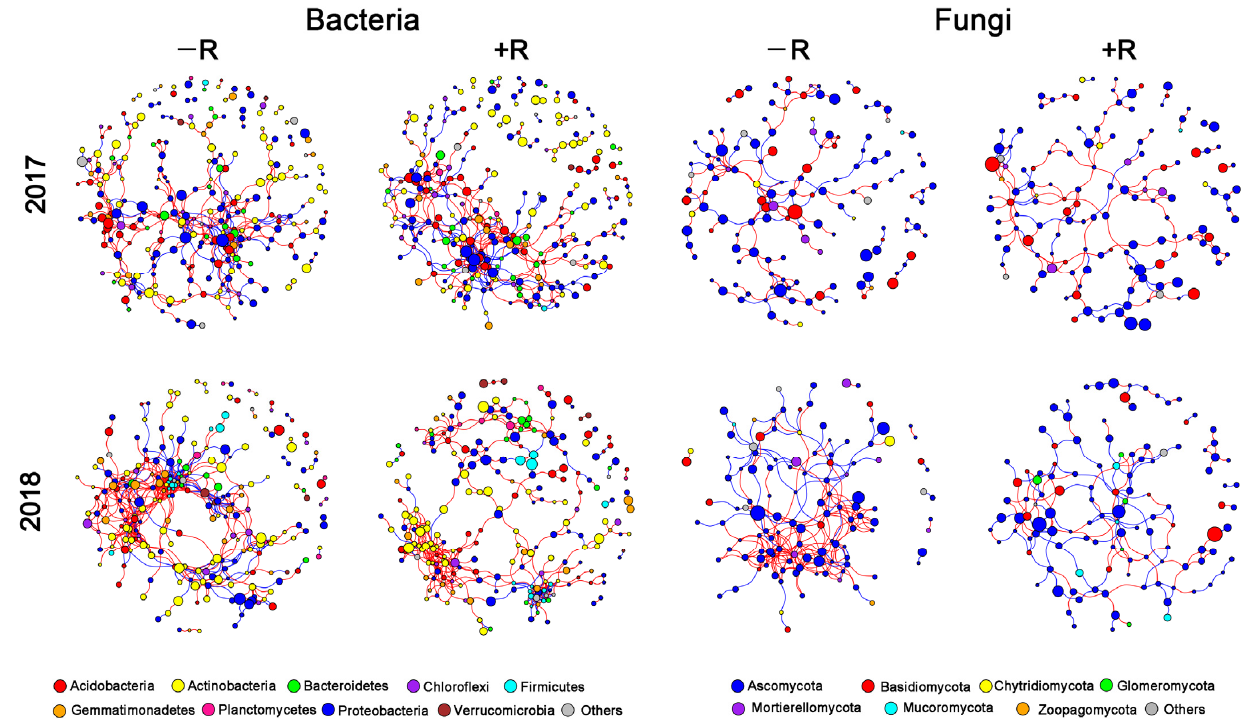
Figure 6. Co-occurrence networks of soil bacterial and fungal communities in residue removal ( − R) and residue retention treatments (+R). The red and blue lines indicate positive and negative connections between the nodes, respectively. The size of each circle represents the relative abundance of each node.